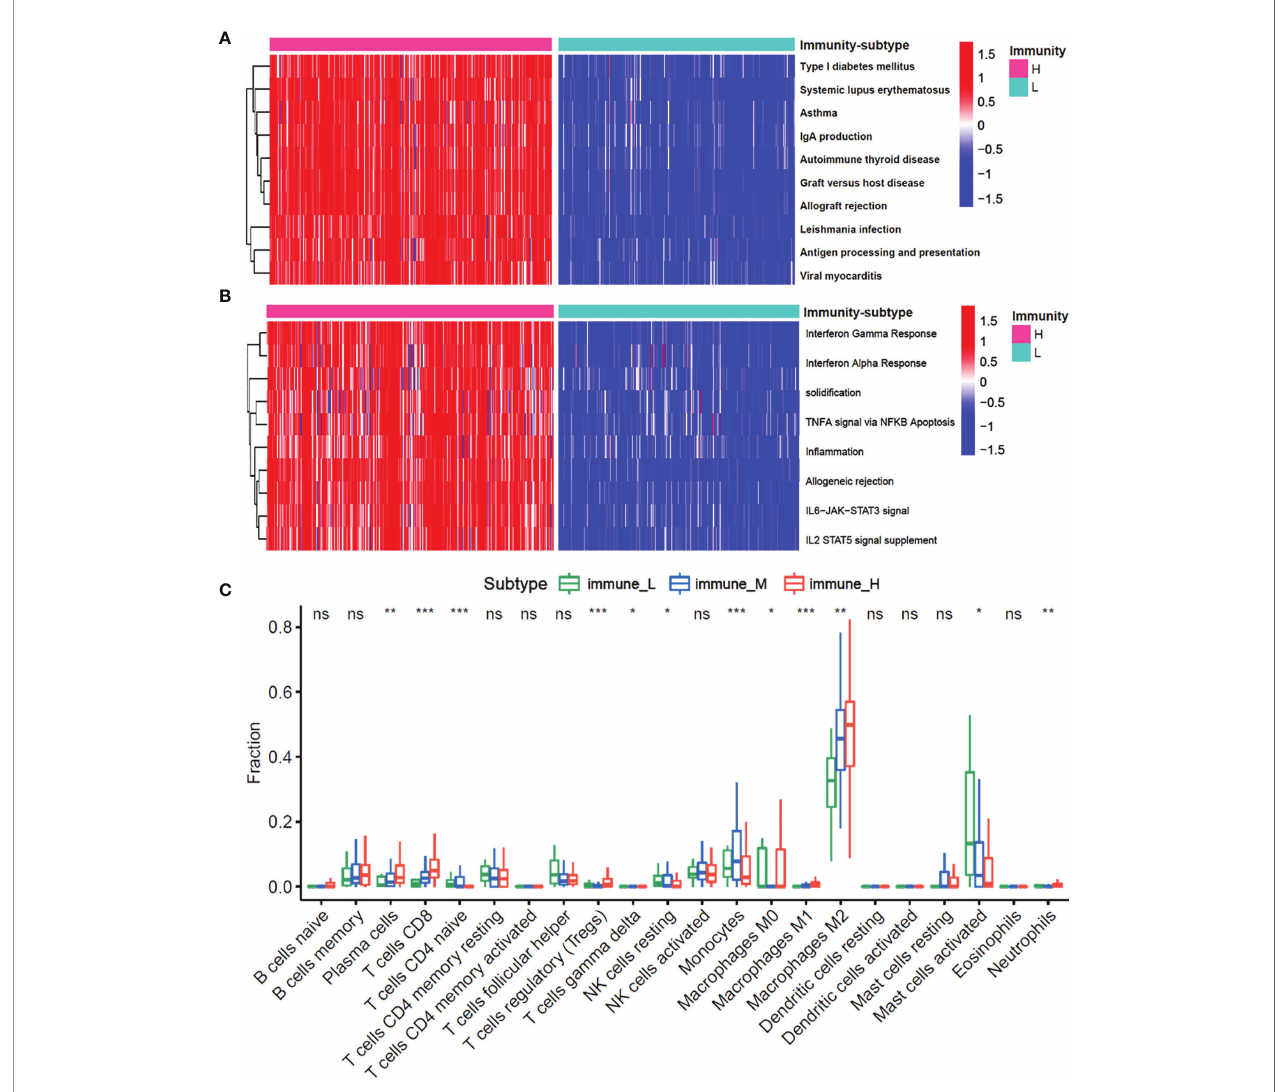
FIGURE 3 | The enrichment molecular pathways and immune cells in fi ltration among three immunity-subgroups of glioma. (A, B) Heatmap shows the GSVA score of top 10 KEGG pathways (A) and 50 hallmarks pathways (B) curated from MSigDB between immunity-H and immunity-L subtypes. (C) The abundance of each 22 types of in fi ltrating cell in three immunity-subtypes. *P ≤ 0.05, **P ≤ 0.01, ***P ≤ 0.001. ns, no signi fi